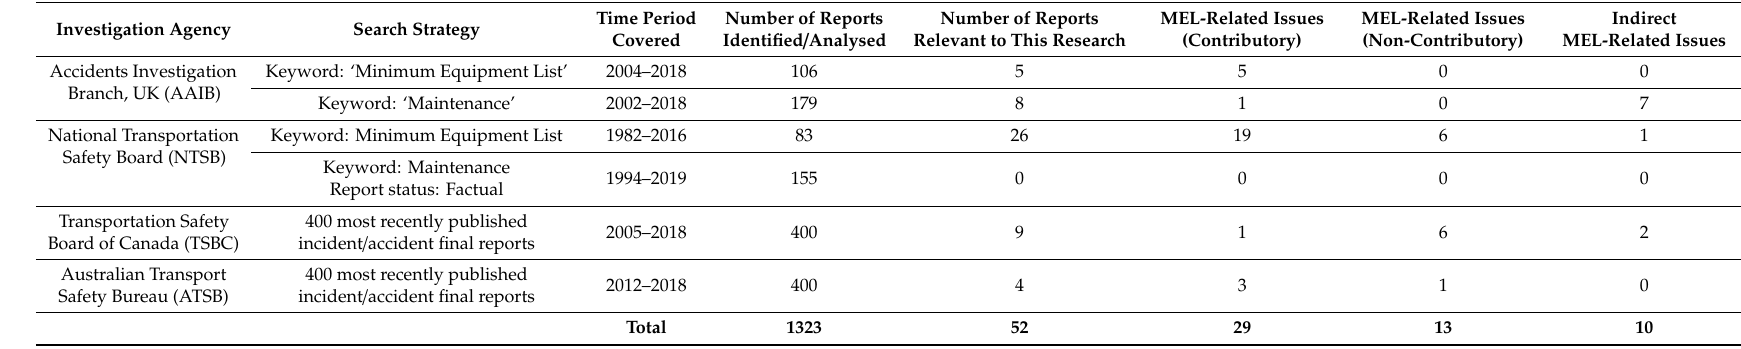
Table 4. Results of the search strategy and filtering of reports.